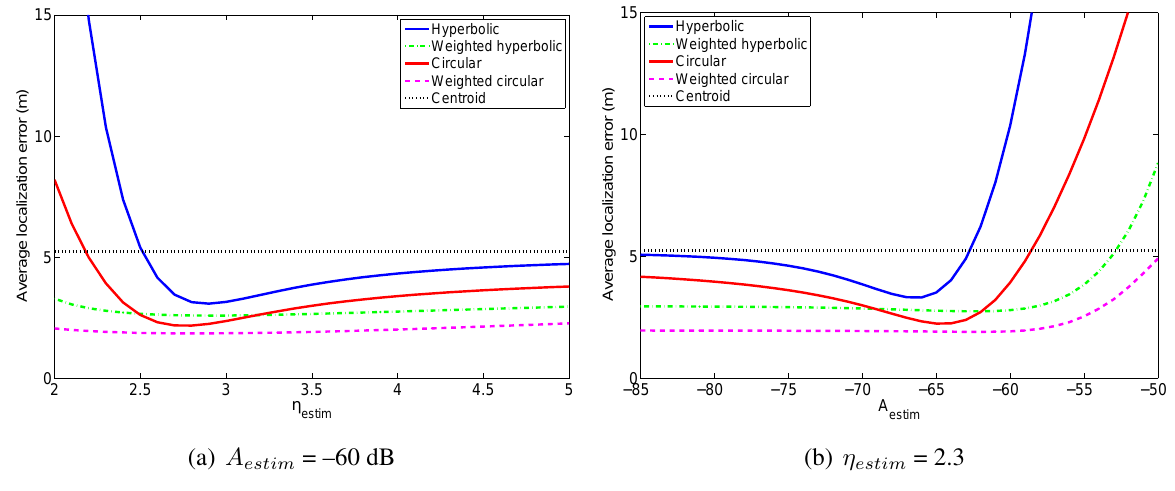
Figure 11. Average localization error in the wireless sensor network experiment for different values of η and A estim estim